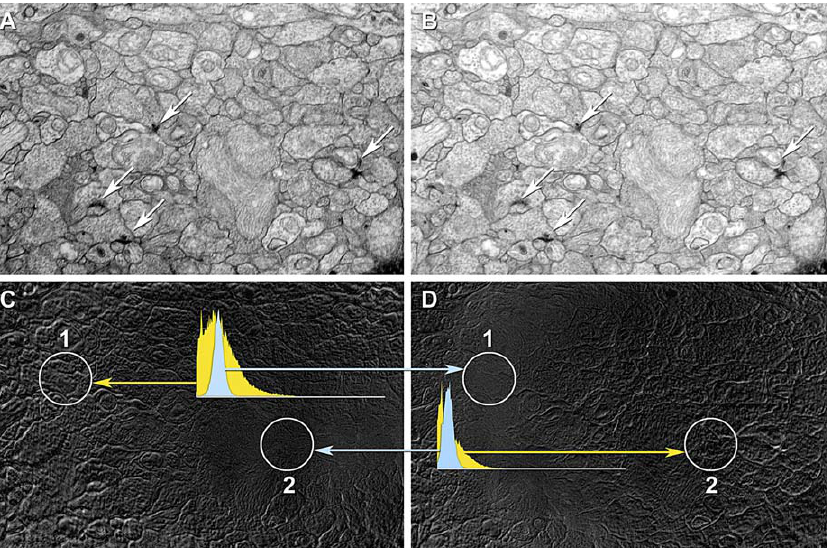
Figure 4. Distortions in Overlapping Tile Regions Visualized on Film Capture of ssTEM Data A typical low magnification (3,000 3 ) field for synaptic screening in the rabbit inner plexiform layer was captured on a Hitachi H-600 with film images at ’ 25% overlap. (A and B) represent part of the overlapping fields with slightly different densities due to the auto-exposure of different images. (C and D) represent the difference of (A and B) after translational/rotational best alignments for two regions (circles 1 and 2). When imagery in circle 2 is aligned best (C) the regions in circle 1 are shifted and have a higher image dispersion. The same is true when imagery in circle 1 is aligned best (D). The quality of alignment is quantified by normalized intensity histograms of corresponding patches. When spots are well-aligned (blue) the histograms are narrow, when poorly aligned (yellow) the intensity variance is high. The two spots are 6 l m apart. The histograms are peak normalized pixel number (ordinate) versus pixel value (abscissa, 0–255). Arrows indicate various ribbon and conventional synapses.